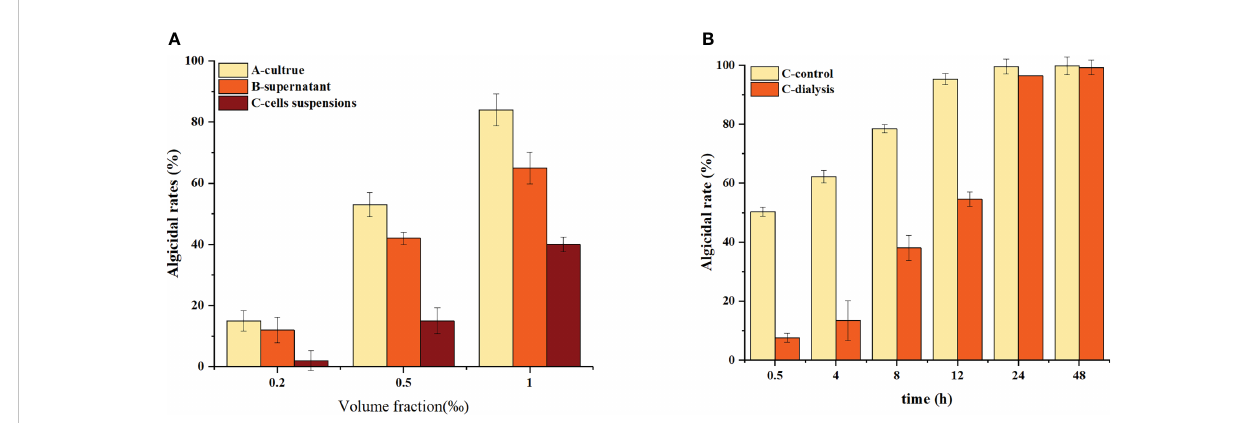
FIGURE 1 Algicidal characteristics of the crude Bacillus spp. extracts. Three replicates were used for error bars (representing the standard deviation). (A) Algicidal effects of the extracts produced using different polar extractants. (B) The effect of temperature on the algicidal activity of the crude extracts. (C) The effect of pH value on the algicidal activity of the crude extracts. (D) Differences in algicidal activities of the crude extracts with different molecular weight